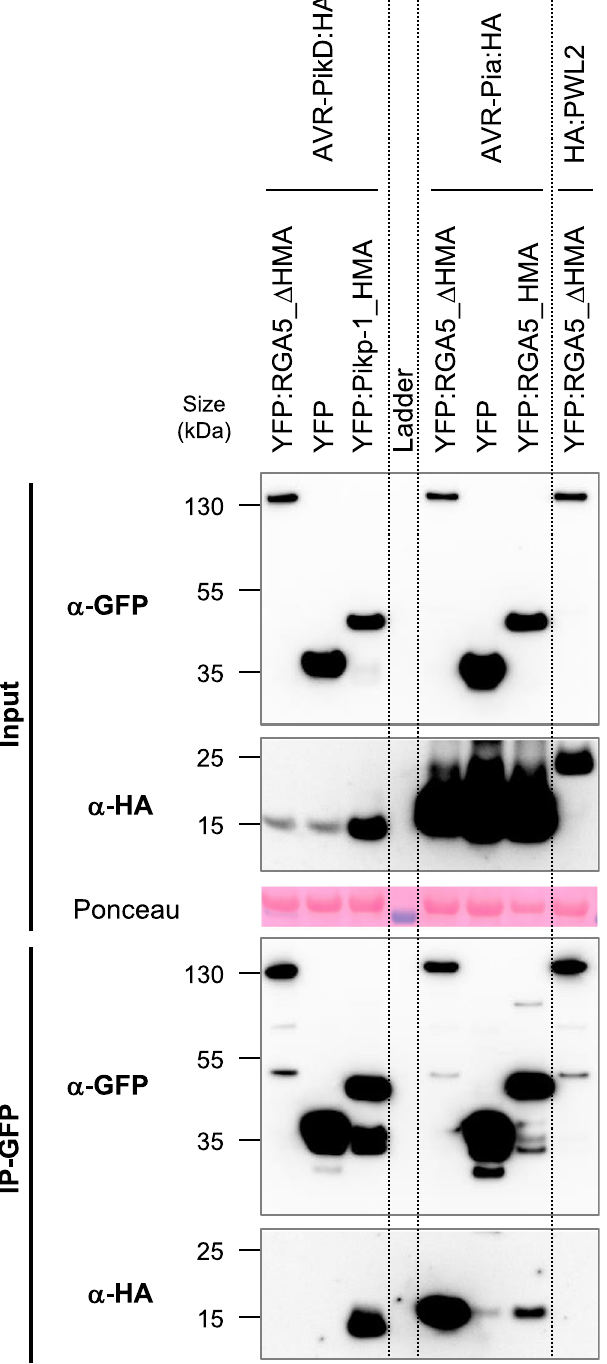
Fig. 6 AVR-Pia associates with RGA5_ Δ HMA but not AVR-PikD. RGA5 deleted of its C-terminal domain (RGA5_ Δ HMA, residues 1 – 996) fused to YFP was transiently co-expressed in N . benthamiana leaves with HA-tagged AVR-Pia, AVR-PikD, or PWL2 (without signal peptides). Proteins were extracted after 48 h and tagged proteins were detected in the extract (input) and after immunoprecipitation with anti-GFP beads (IP-GFP) by immunoblotting with anti-HA ( α -HA) and anti-GFP ( α -GFP) antibodies. Protein loading in the input is shown by Ponceau staining of the large RuBisCO subunit. The HMA domains of Pikp-1 and RGA5 were used as controls as well as the unrelated PWL2 effector of M. oryzae . The experiment was carried out twice with identical